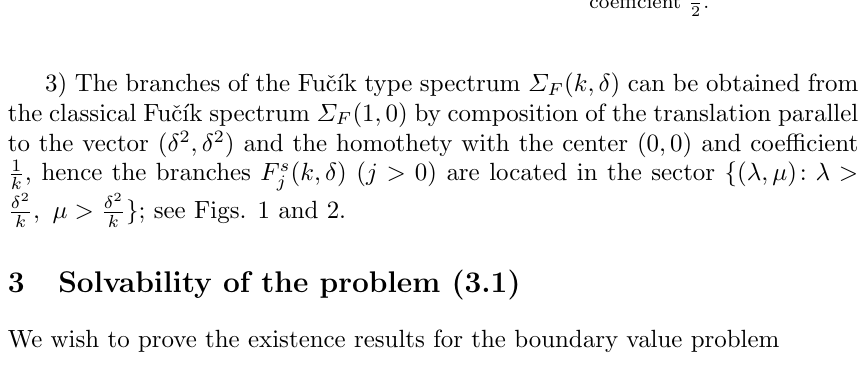
Figure 2. The Fuˇc´ık type spectrum Σ F (2 , 5) (solid) can be obtained from the classical Fuˇc´ık spectrum Σ F (1 , 0) (dashed) by composition of translation parallel to the vector (5 2 , 5 2 ) and homothety with the center (0 , 0) and coefficient 1 2